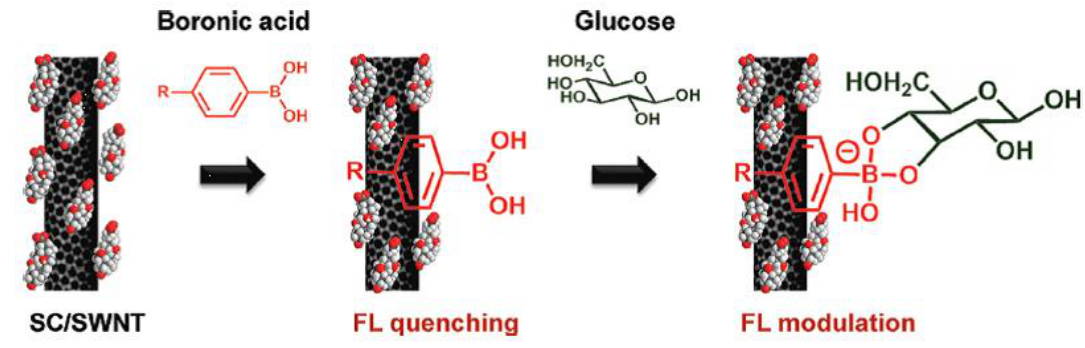
Figure 6. Binding of arylboronic acids to the surface of single-walled carbon nanotubes (SWCNTs) cause quenching of the near-infrared fluorescence, which reappears upon binding of glucose (Reprinted with permission from [64]. Copyright 2012 American Chemical Society).